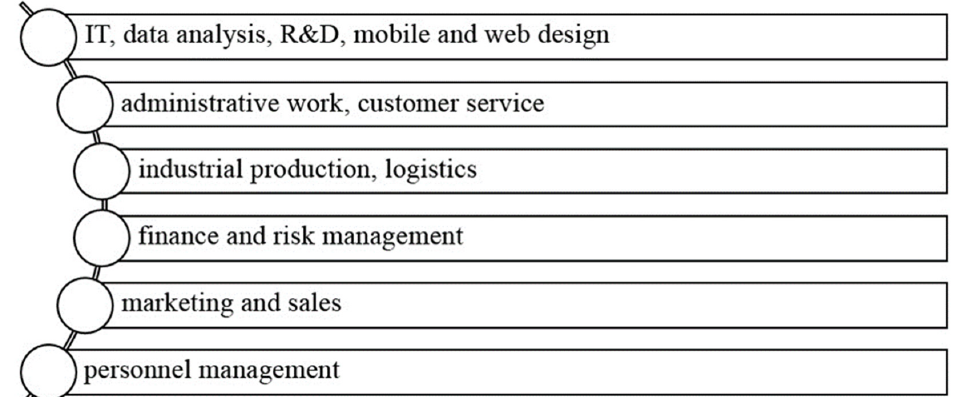
Figure 2. Areas of activity most sensitive to the availability of soft skills. Source: the authors based on data from (Kyllonen 2013).